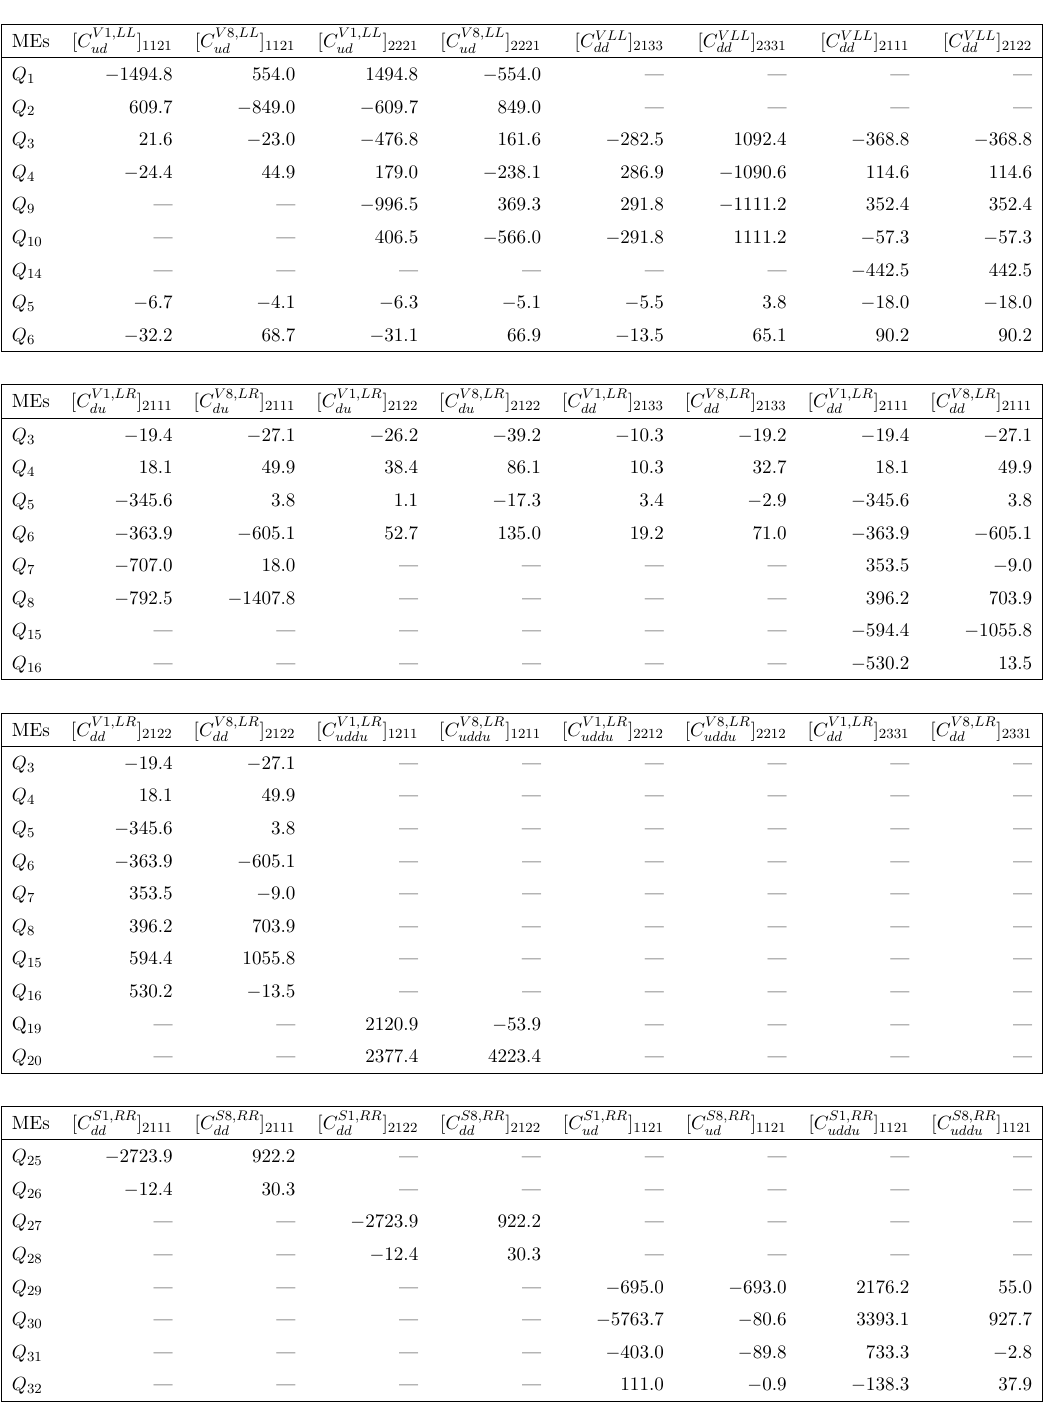
( µ ) (see (2.9) for definition) are shown. Here the first index a Table 1 . The values for p (2) ew , µ had ba refers to the matrix elements in the BMU basis as shown in the left most column and b is for the Wilson coefficients in the JMS basis shown in the top row of the table. The corresponding p (0) be obtained through the relation